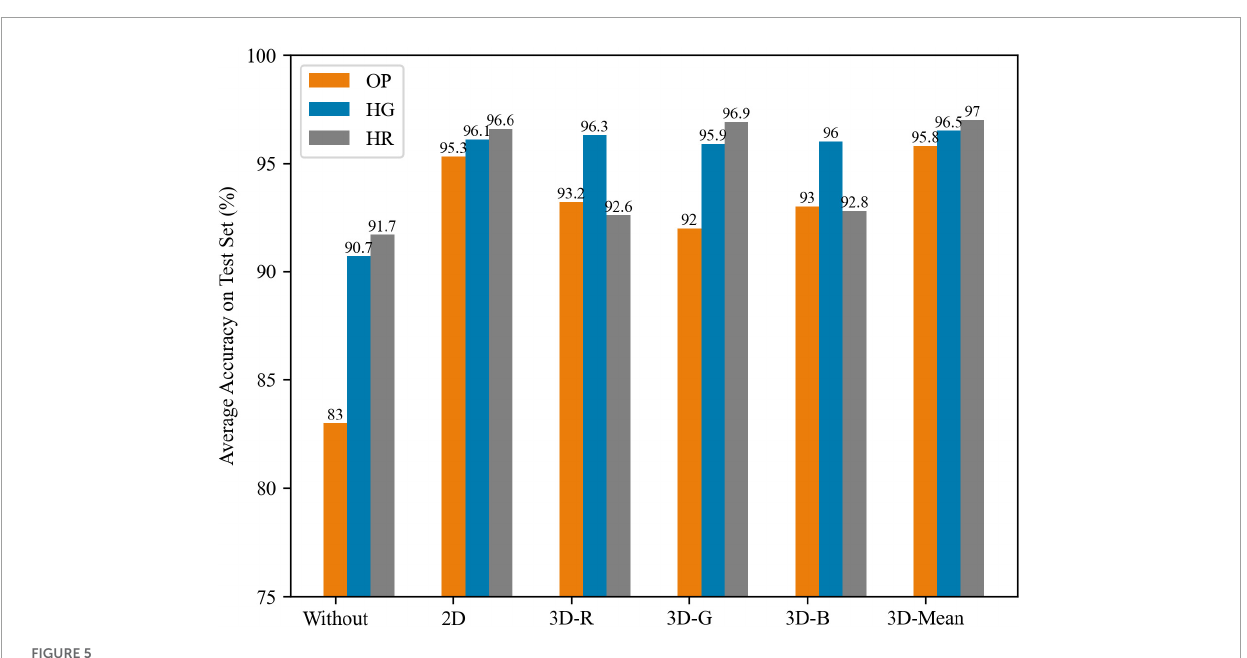
extracting complex features and structures since it only depends on convolution